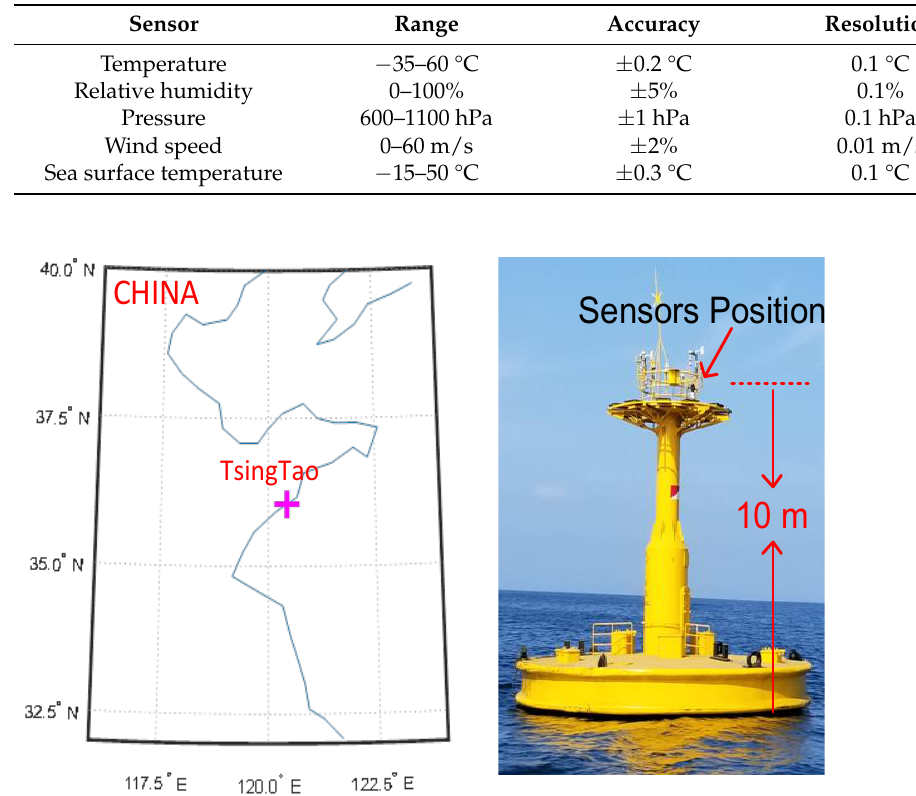
Figure 2. Geographical location of the offshore buoy and sensor location. EDH data from 18:00 LST on 13 September to 18:00 LST on 15 September 2017 were selected for the analysis of the EDH variation. The daily variation of the EDH is shown in Figure 3.